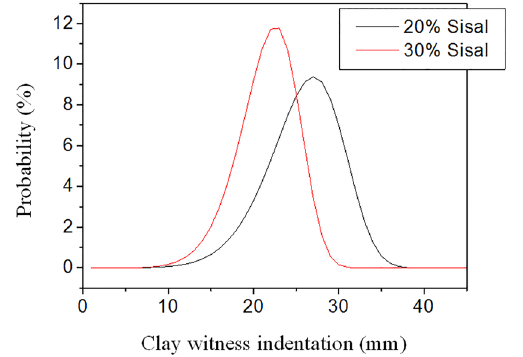
Figure 5. Weibull density of probability function for the depths of indentation for the MAS with 20 and 30 vol.% sisal fiber